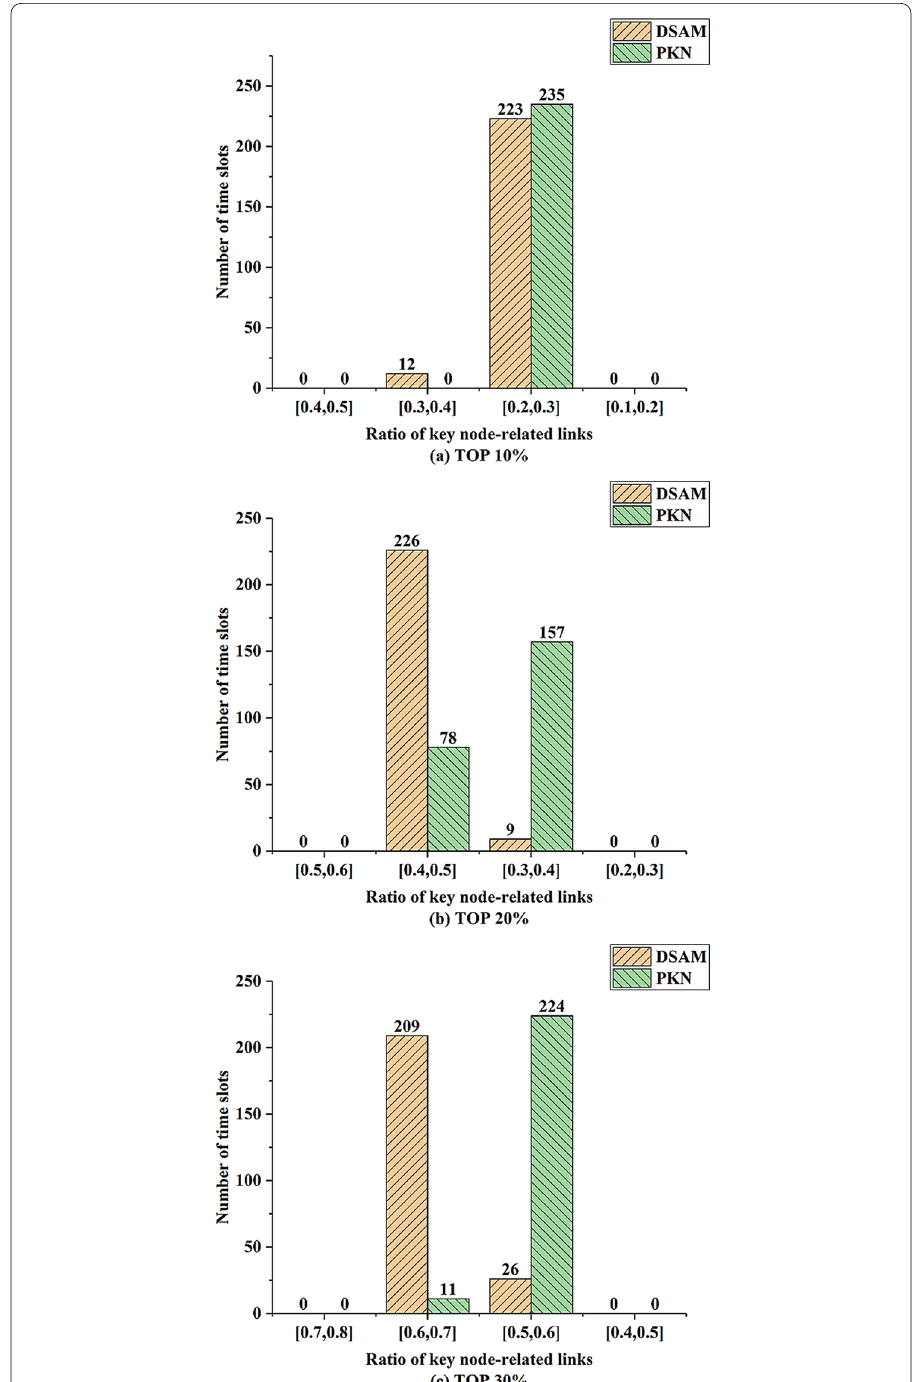
Fig. 8 The ratio of key node related links in each time slot in